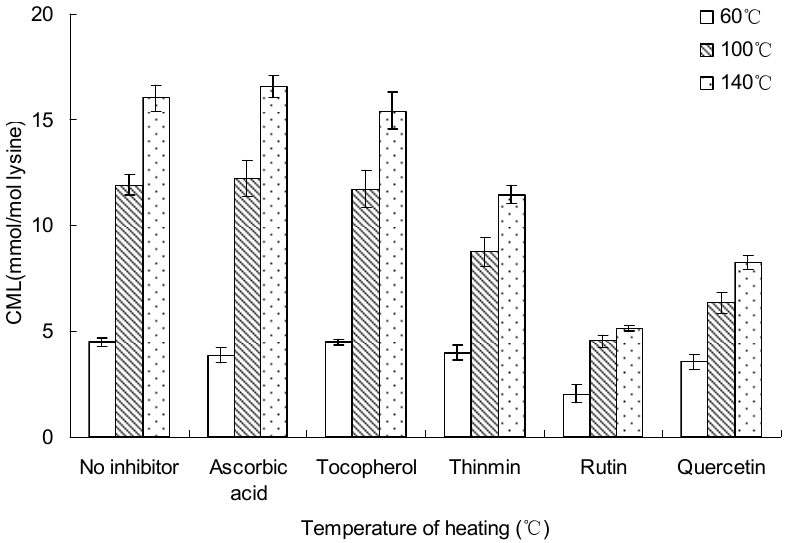
Figure 6. Inhibition temperature on inhibiting the formation of CML in glucose-lysine model systems during microwave heating. The heating time was 20 min and the concentration of inhibitor was 10 mM. Data points are the mean of triplicate measurements ± SD.